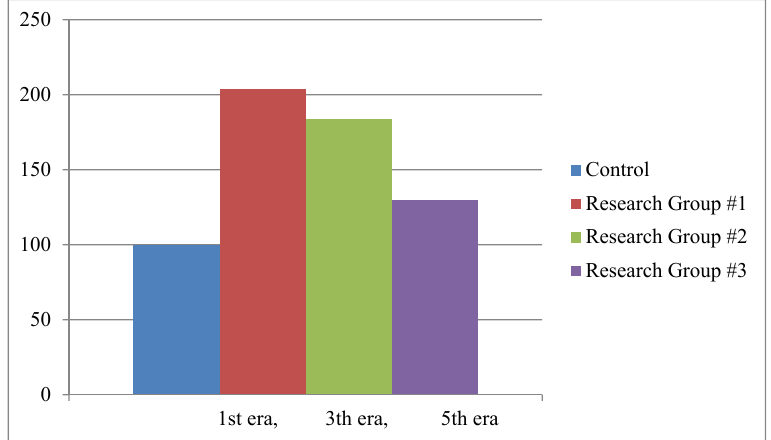
Fig. 2. Concentration of malonic dialdehyde in blood of rats in the dynamics of development of immobilization stress (% of